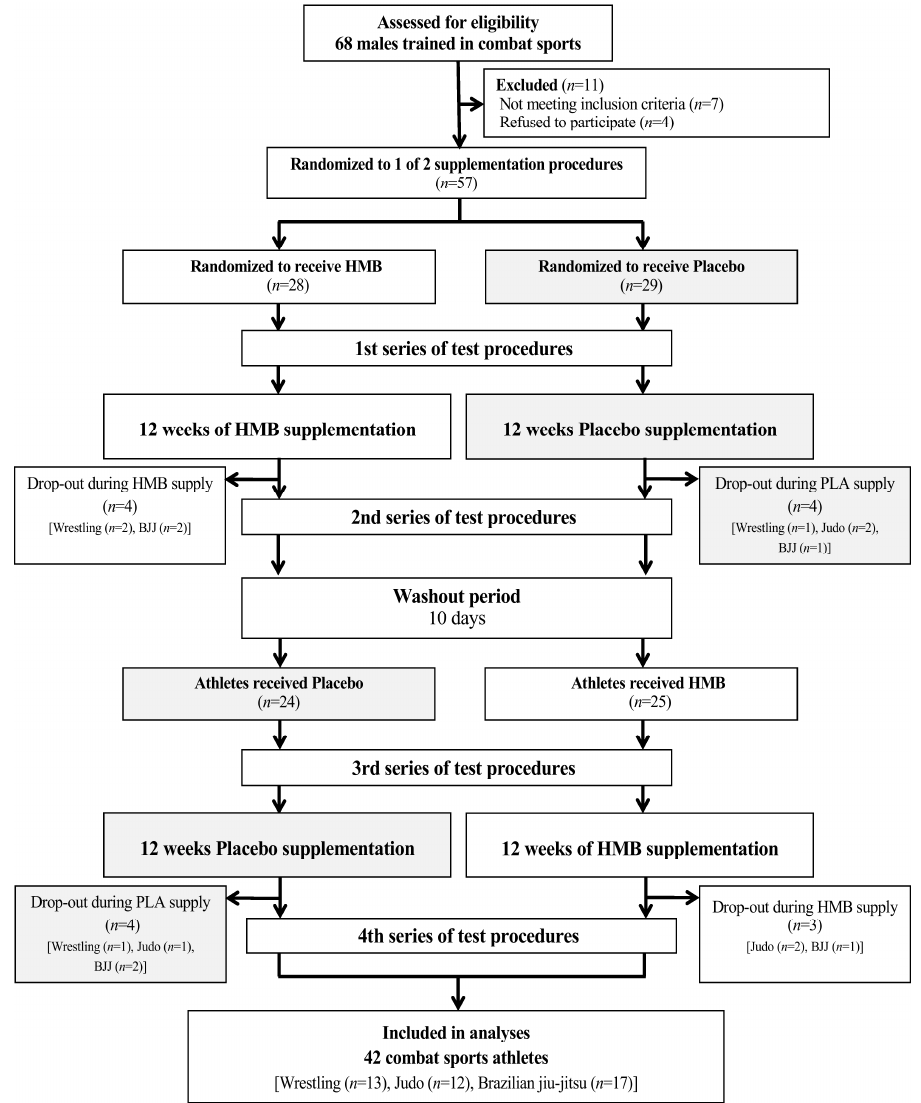
Figure 1. A flow chart of the study design. Abbreviations: BJJ, Brazilian jiu-jitsu; HMB, β -hydroxy- β -methylbutyric acid; PLA, placebo.